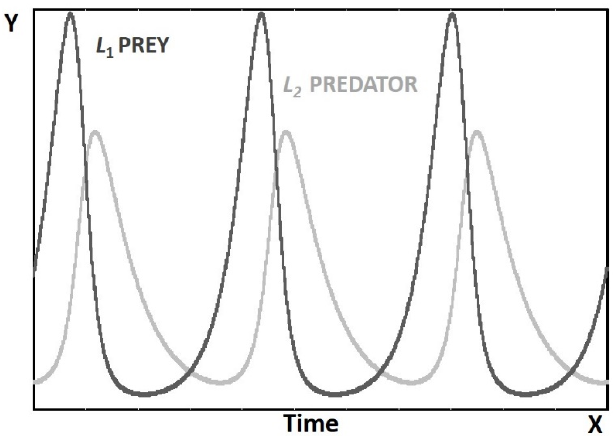
Figure 2. The result of the simplest version of the Lotka–Volterra 2-stock model.